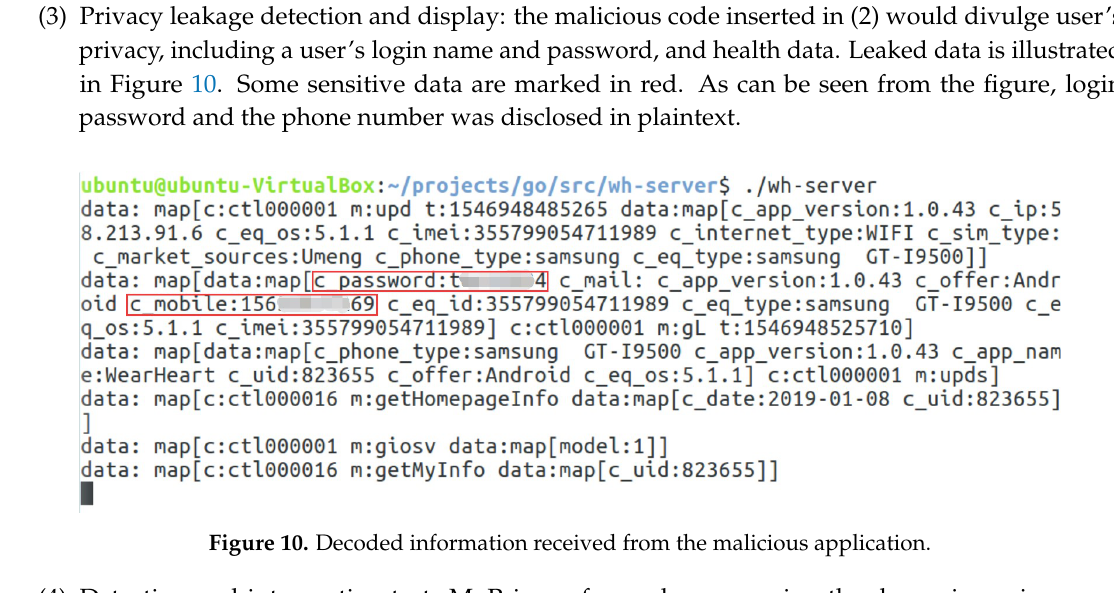
Figure 10. Decoded information received from the malicious